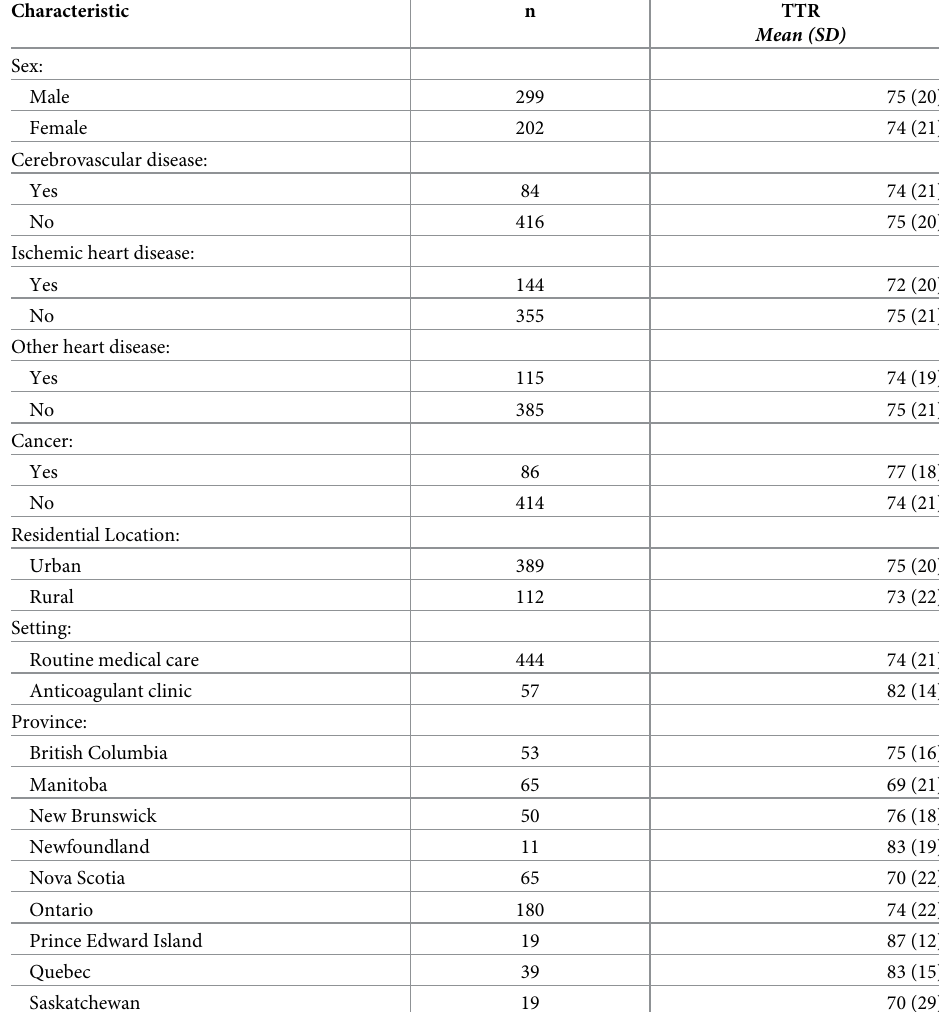
Table 4. Summary of Time in Therapeutic Range by factors (TTR) (n =